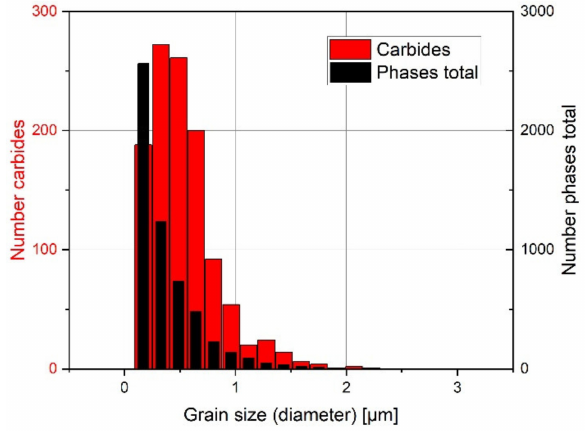
Figure 9. Grain size distribution of all phases in total (black) and carbides (red) from EBSD measure- ments in Figure 6.